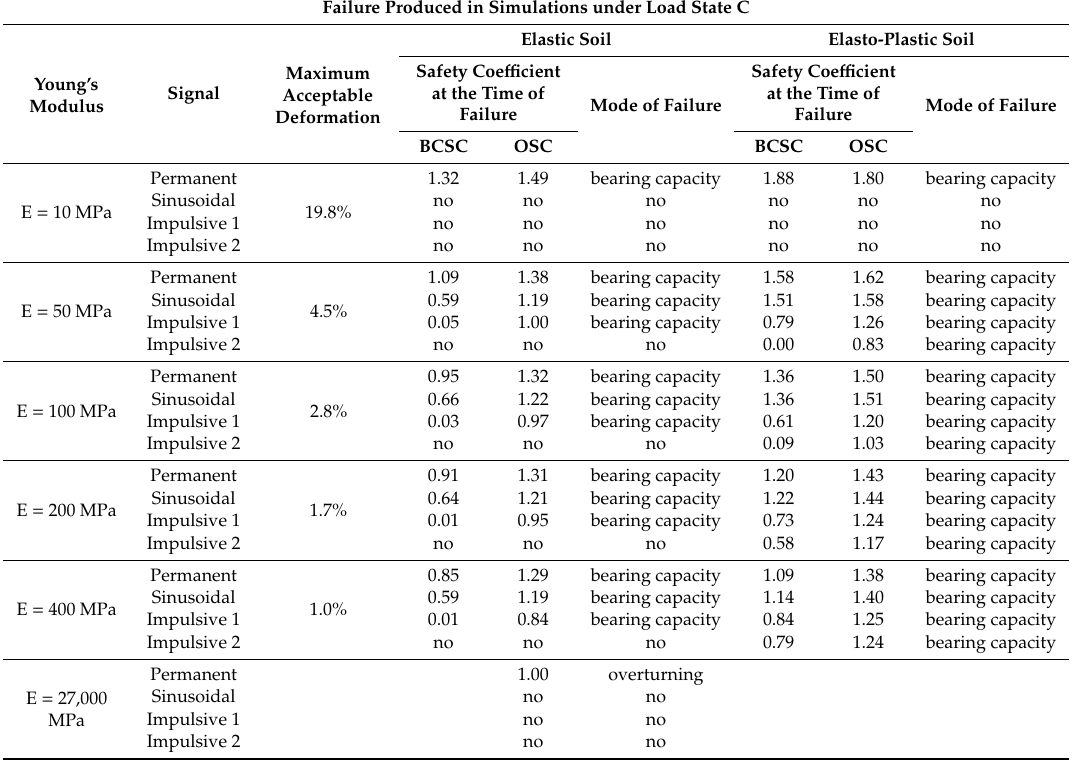
Table 10. Mode of failure in simulations under load state C and safety coe ffi cients obtained at the time of failure of the crown